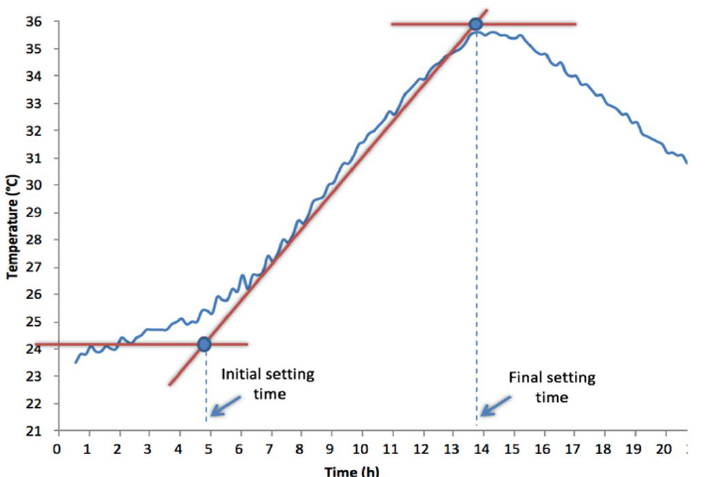
Figure 4. Scheme representing the determination of the initial and final setting times by the tangent method.